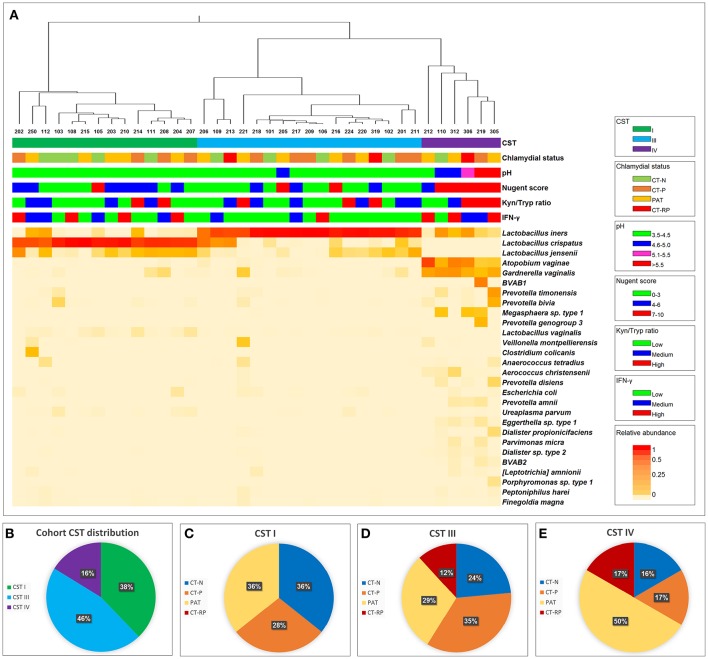
Vaginal taxonomic distribution. (A) Heatmap of vaginal microbial taxa detected in women who were either C. trachomatis negative (chlamydial status: CT-N in green), C. trachomatis positive single infection (CT-P in orange), samples were taken from women with current infection at second and third visit, post antibiotic treatment (PAT in yellow) and C. trachomatis positive with repeated infection in the past year (CT-RP in red). Relative abundance of each taxa (species level where possible) is presented by color, with red indicating higher abundance, and lighter shades of orange indicating lower abundance. To the right of the heatmap is the nearest species as assigned by modified vaginal specific 16S database (Srinivasan et al., 2012), with the addition of several indole producing bacteria known to be found in the human vaginal microbiome. For each of the women's sample, CST, chlamydial status, pH, Nugent score, kynurenine/tryptophan ratios and vaginal IFN-γ response data are presented. (B) Taxonomic distribution of CST I, III, and IV in our overall cohort. (C) Women's chlamydial infection status distribution (CT-N, CT-P, PAT, and CT-RP), among CST I, (D) CST III and (E) CST IV, presented as percentages.